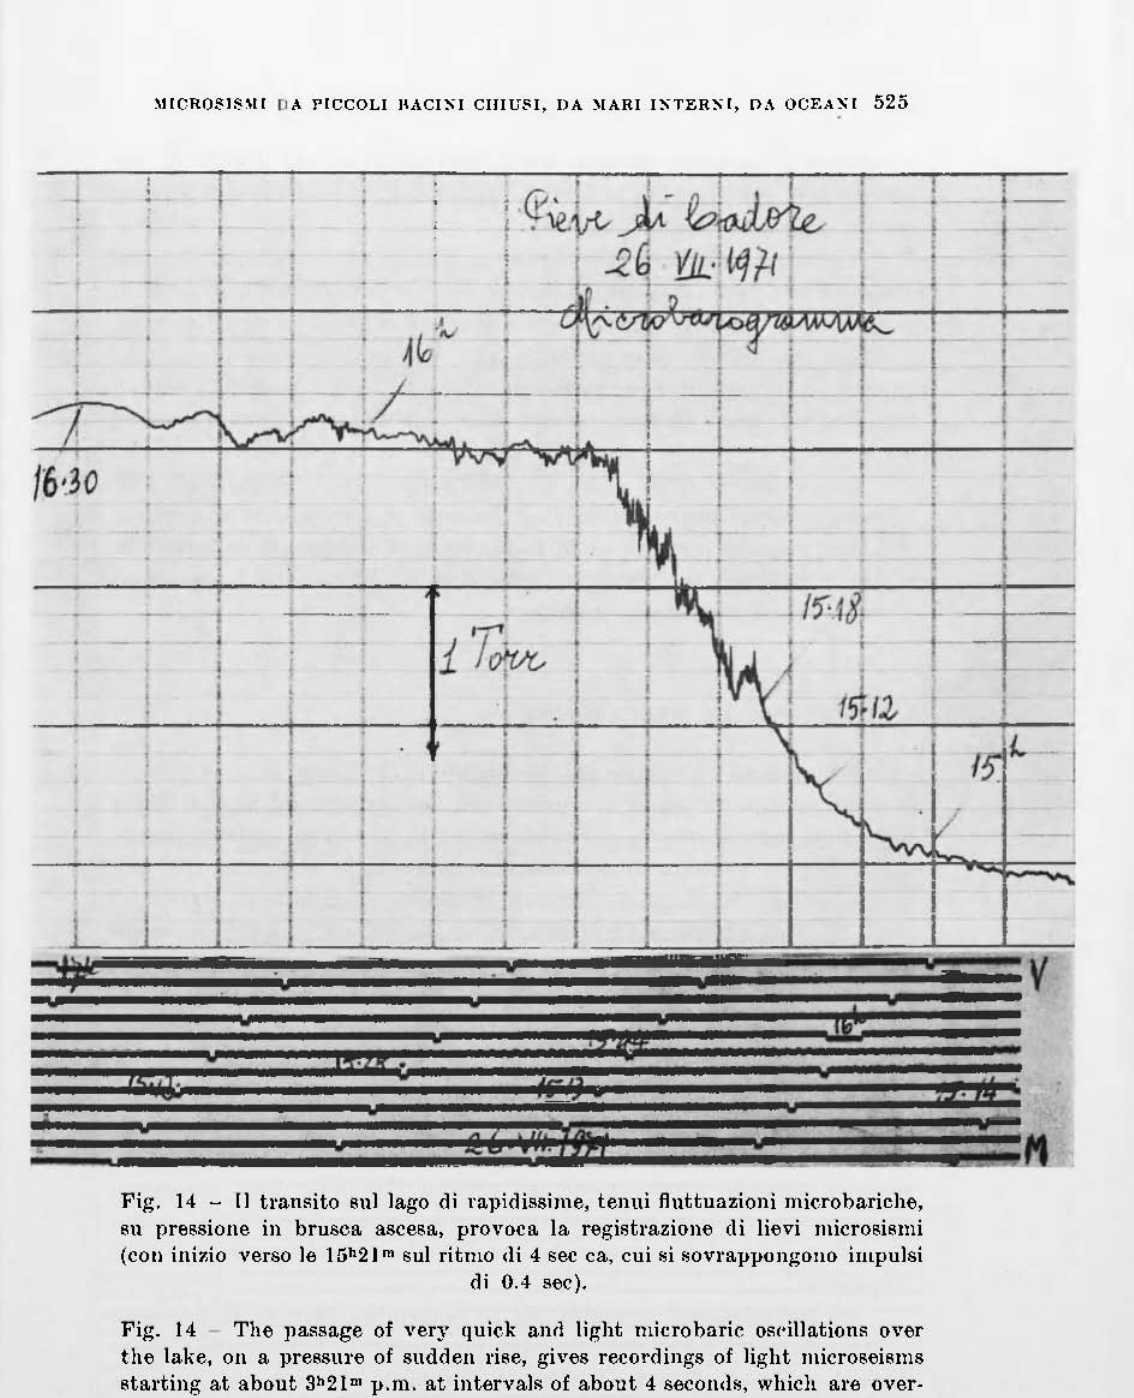
Fig, 14 ~ Il tran~ito ~ul lago di rapidissime, tenui fluttuazioni microbariche, ~u prel!.Sione in brusca ascesa, provoca la registrazione di lievi llIicrosi~llli (con inh:io verso le 15 h 21 rn sul ritmo di 4 see ca, cui ~i ~oyrappongollo iIlLpulsi di 0.4 see). Fig, 14 ~ The lla~sage oi ver}' quid allrl light microbaric o~(·illation~ over the lake, on a prellSUl'e of sudden ri~e, gives reeordings of light llIicrosei~IllS ~tarting at about 3 h 2l m p,m, at intervals of about 4 seeond~, which are over· lappe([ by impulses of 0·4